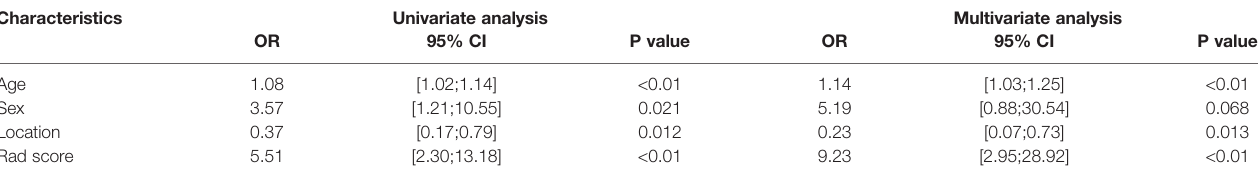
TABLE 2 | Univariate and multivariate logistic regression analysis of the clinic-radiological features. Characteristics